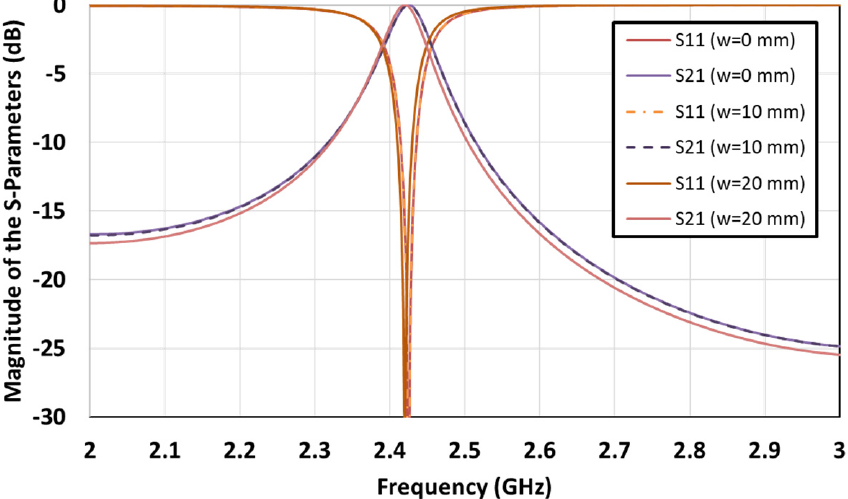
Figure 5. Magnitude of the reflection (S 11 ) and transmission (S 21 ) coefficients according to the width ( w ) of the LED lines.